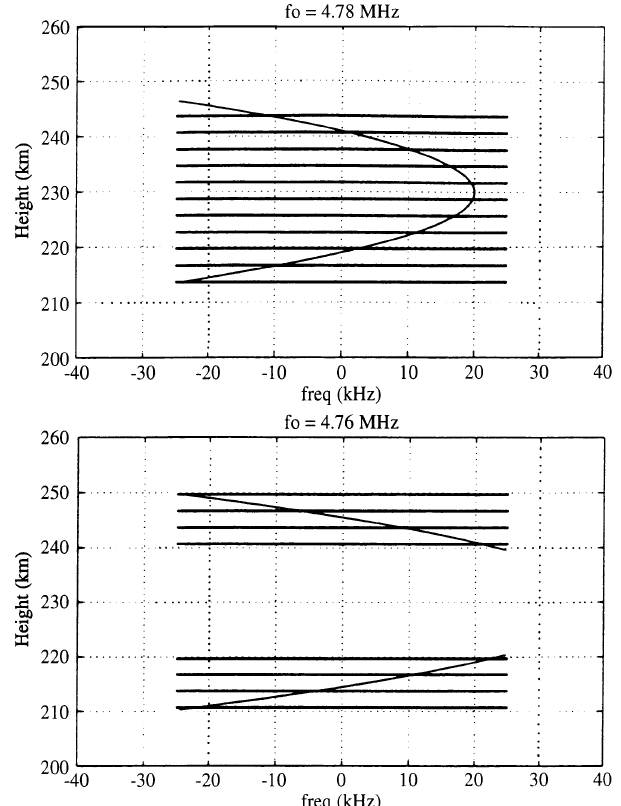
Fig. 1. Parabolic height distribution of the plasma-line frequency with scale height of 65 km showing two different tunings of the 50-kHz receiving filter and the corresponding height cells contribu- ting to